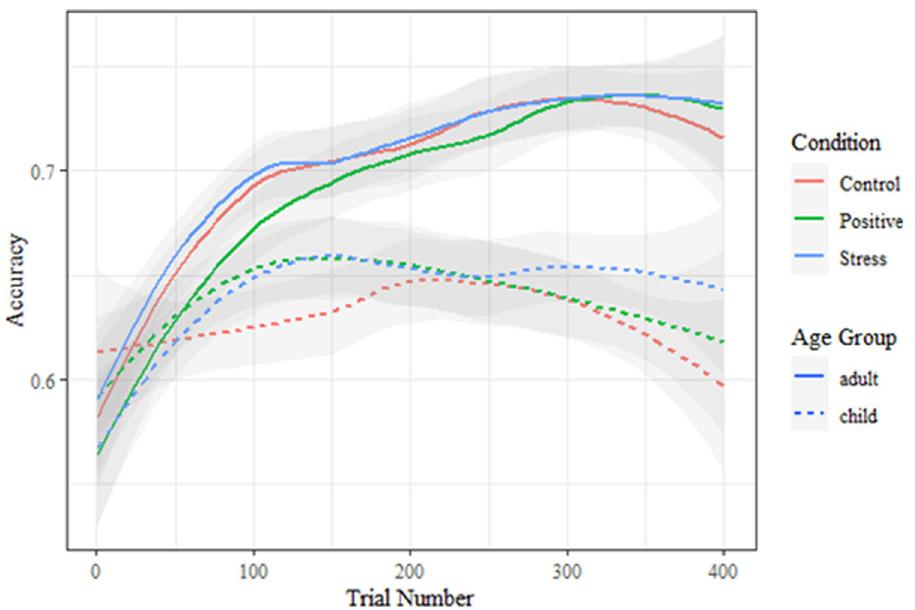
Fig 2. LOESS-smoothed accuracies for each experimental group over the course of the training.